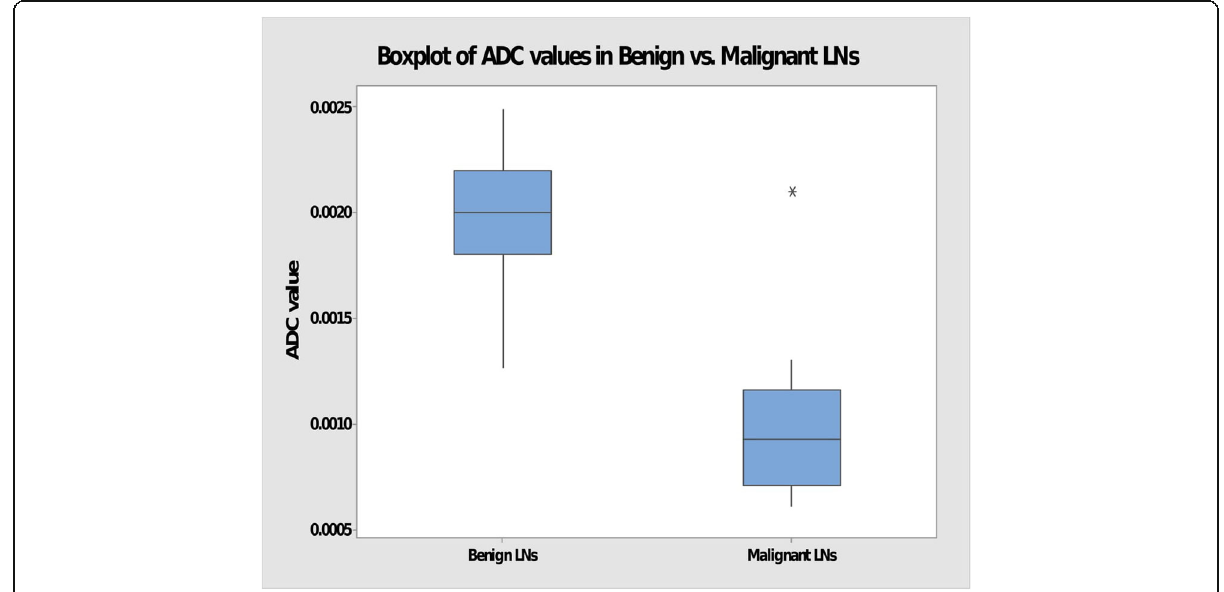
Fig. 3 Boxplot of ADC values in benign versus malignant lymph nodes